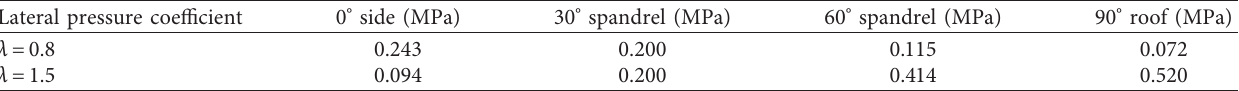
yc ) when the surrounding rock changes from elastic to plastic state.